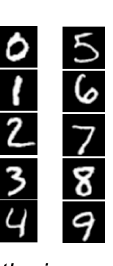
Figure 4 – Examples of the images in the MNIST